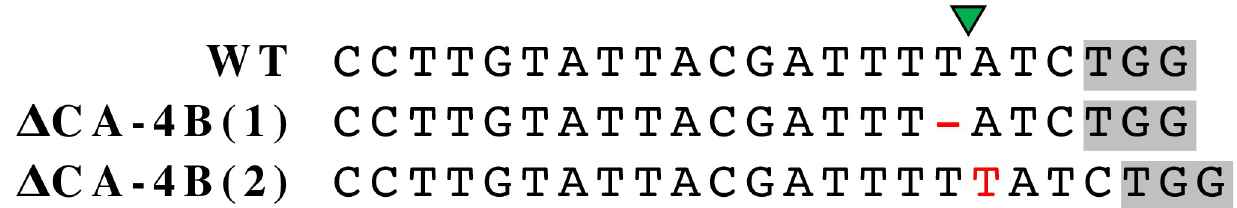
Fig 6. Recovery of CA-4B site-directed mutants by RNP-targeting. Two indels (red) in 034r from two CA-4B variants (1 and 2) were detected and sequence verified to support the possibility of site-directed mutagenesis by preassembled Cas9 protein-sgRNA RNPs in the PBCV-1 a064r homologous gene. PAM site, gray. Green triangle, Cas9/sgRNA cleavage site. WT, wildtype sequence.